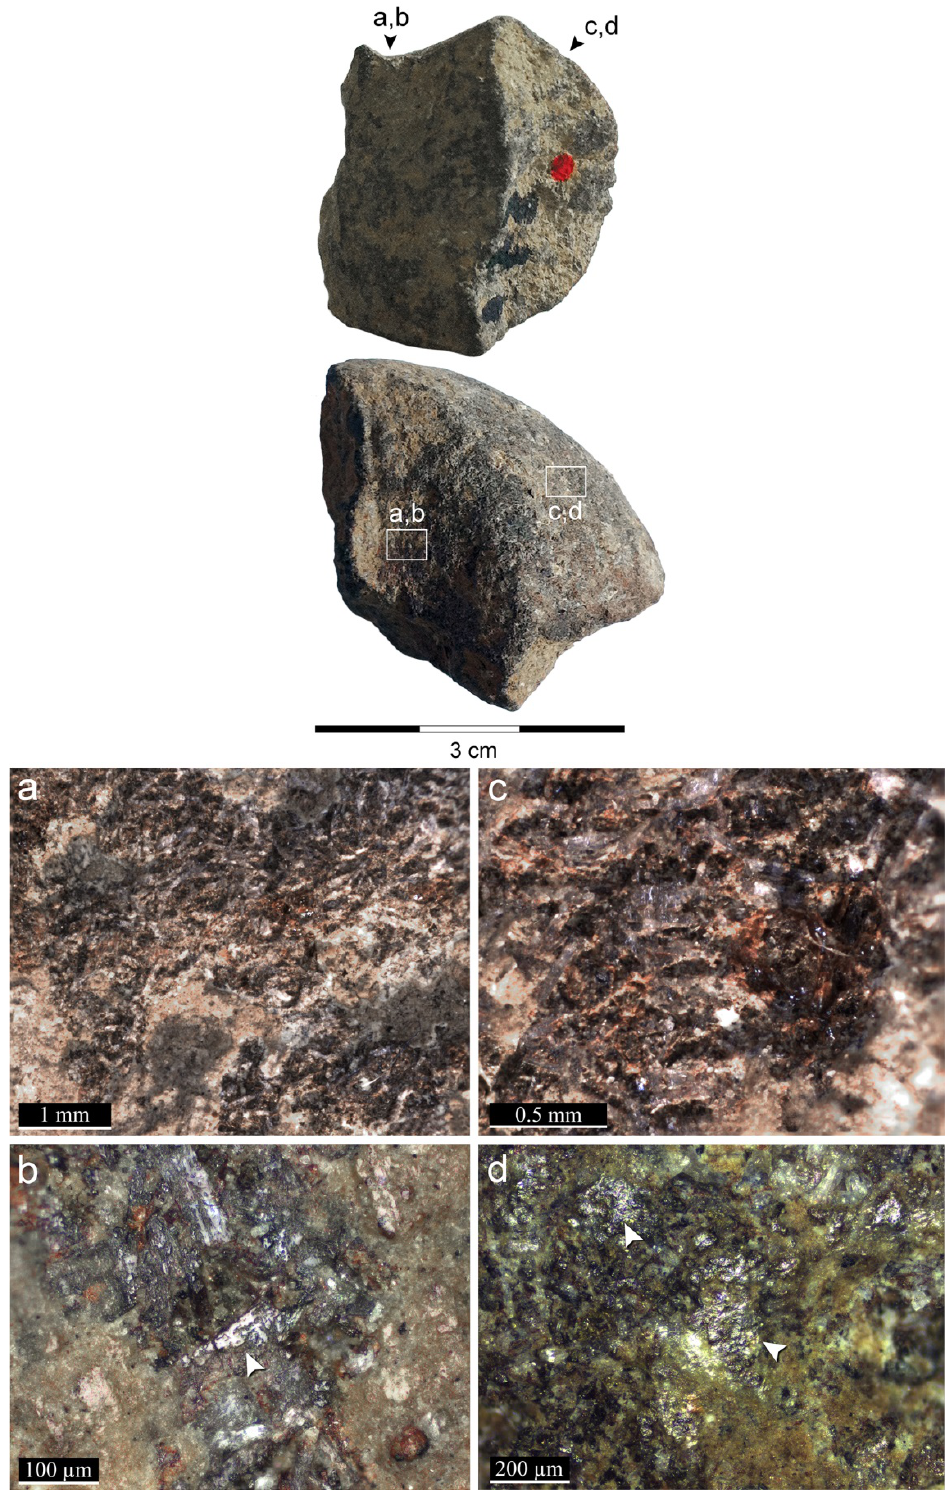
Figure 4: Artefact number 172 with a side view showing the concave bottom of the groove and walls extending outward. Locations of microphotographs are indicated by arrows. Traces inside the groove interpreted as having been produced by contact with medium hardness material such as bone or wood: a) flat peaks with flattening extending into the lower surfaces indicating contact with medium hardness material such as bone, wood or reeds (x20), b) micro-polish developed on protruding surface indicated by the white arrow showing directionality pattern parallel to the main axis of the groove (x200). Traces on the perimeters interpreted as having been produced by the contact with a hard stone: c) extremely flat peaks with sharp edges (x50), d) rough bright polish developed on protruding points indicated by the white arrows